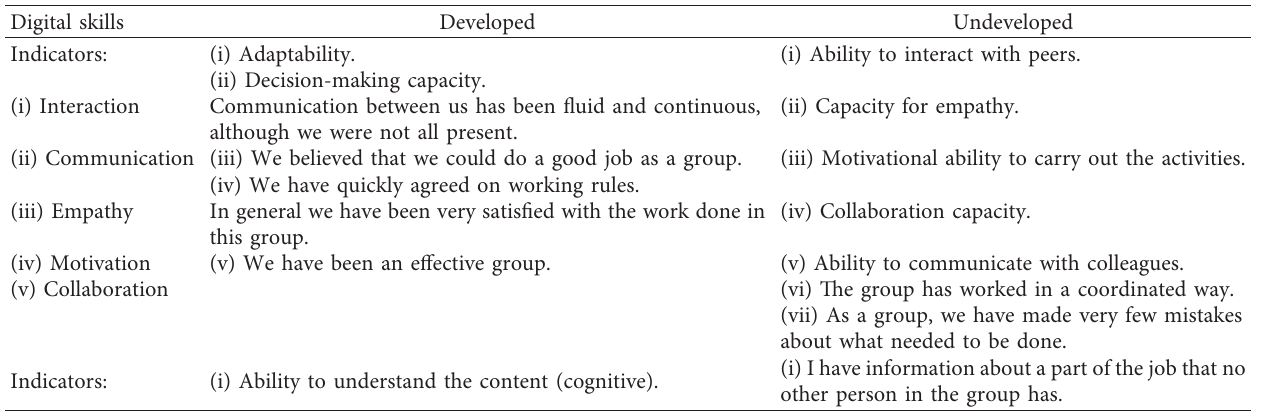
Table 3: Results of developed and not developed